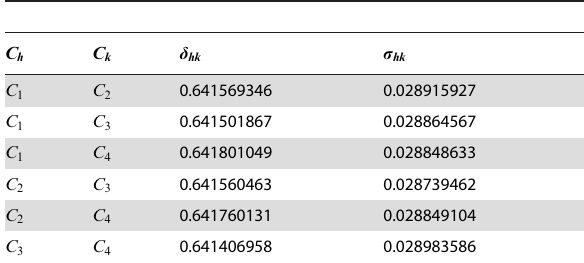
Table 4. Scenario 2 average between distance and relative standard deviation for communities simulated with b ~ 50 and a ~ 25 .